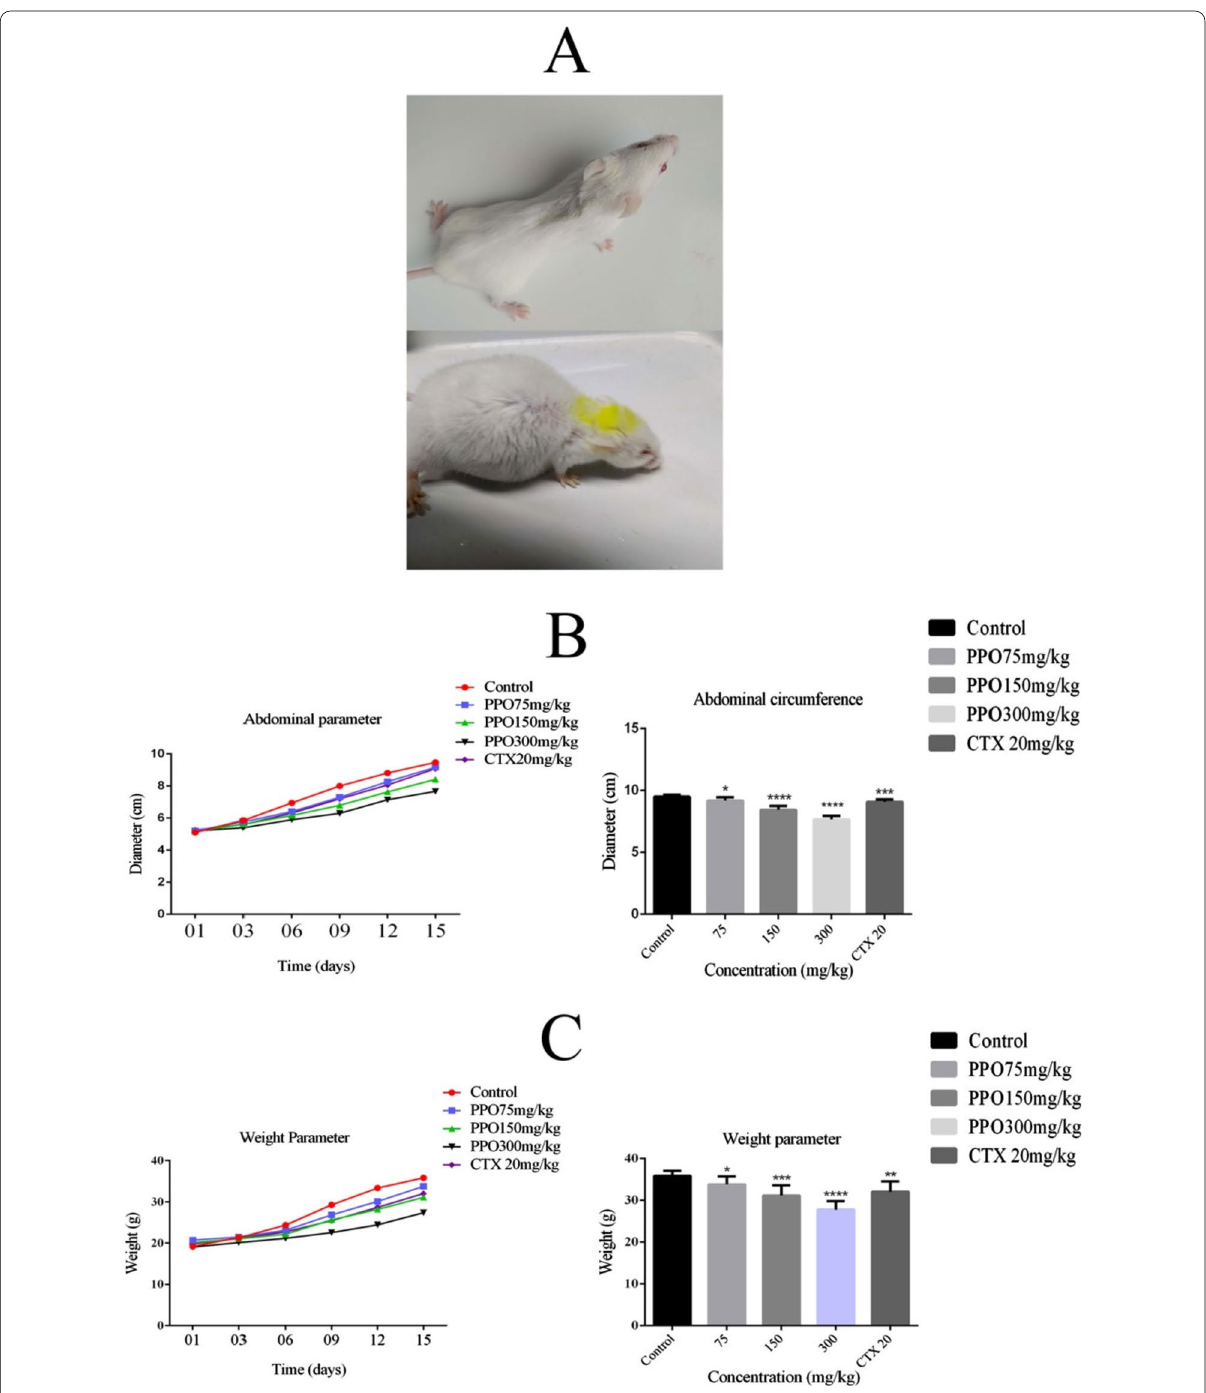
Fig. 2 The effects of H22 malignant ascites on mice model after treating with polysaccharide A Mice photographed before and after developing the ascites. B The abdominal perimeter was observed for 15 days and results suggested that there is a significant difference between Control and polysaccharide treated group. C Weight perimeter was also observed for 15 days and shows the significant difference between Control and polysaccharide treated group in a dose-dependent manner. *p < 0.05, **p < 0.01, ***p < 0.001. (n ostreatus ), *CTX